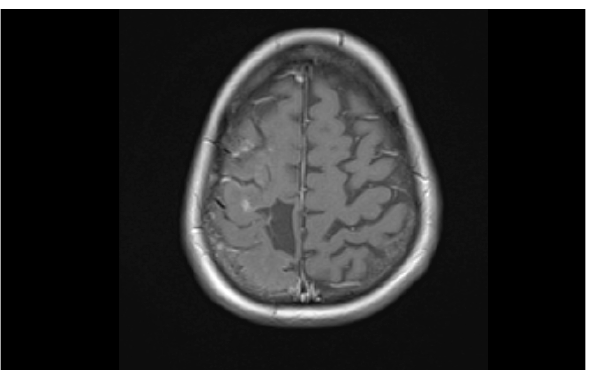
Fig. 1f. Diffusion-weighted MRI scan showing multilocal hy-